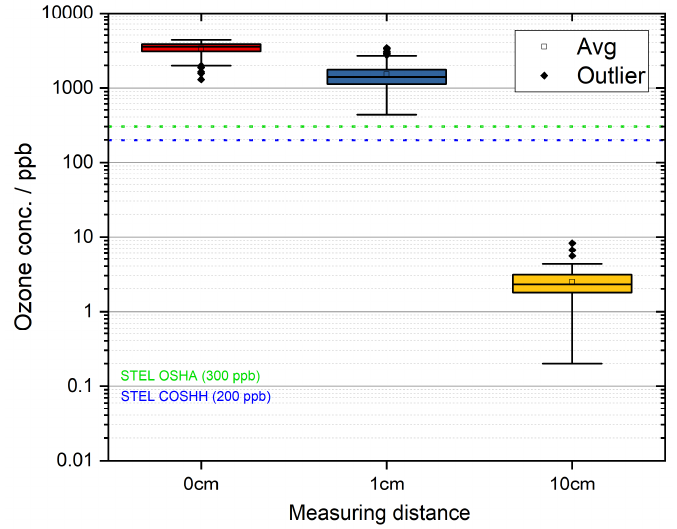
Figure 1. Box plot of ozone concentrations measured at three di ff erent distances of the plasma source (logarithmic Figure 7. Box plot of ozone concentrations measured at three different distances of the plasma source (logarithmic scaling).